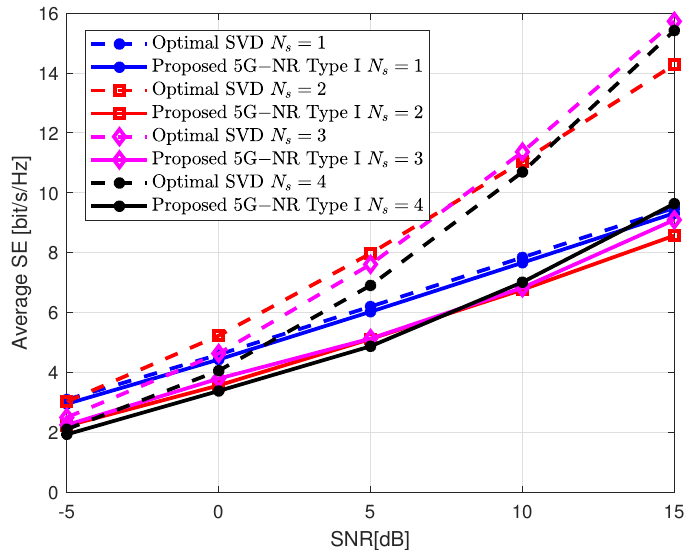
Figure 5. Average SE vs. SNR for SU-MIMO systems assuming 𝑁 𝑡 = 8, 𝑁 𝑟 = 4, and different values of 𝑁 𝑠 . The gNB is implemented assuming a single-panel UPA with two DP polarized antenna elements in the horizontal and vertical dimensions ( 𝑁 1 = 2 and 𝑁 2 =